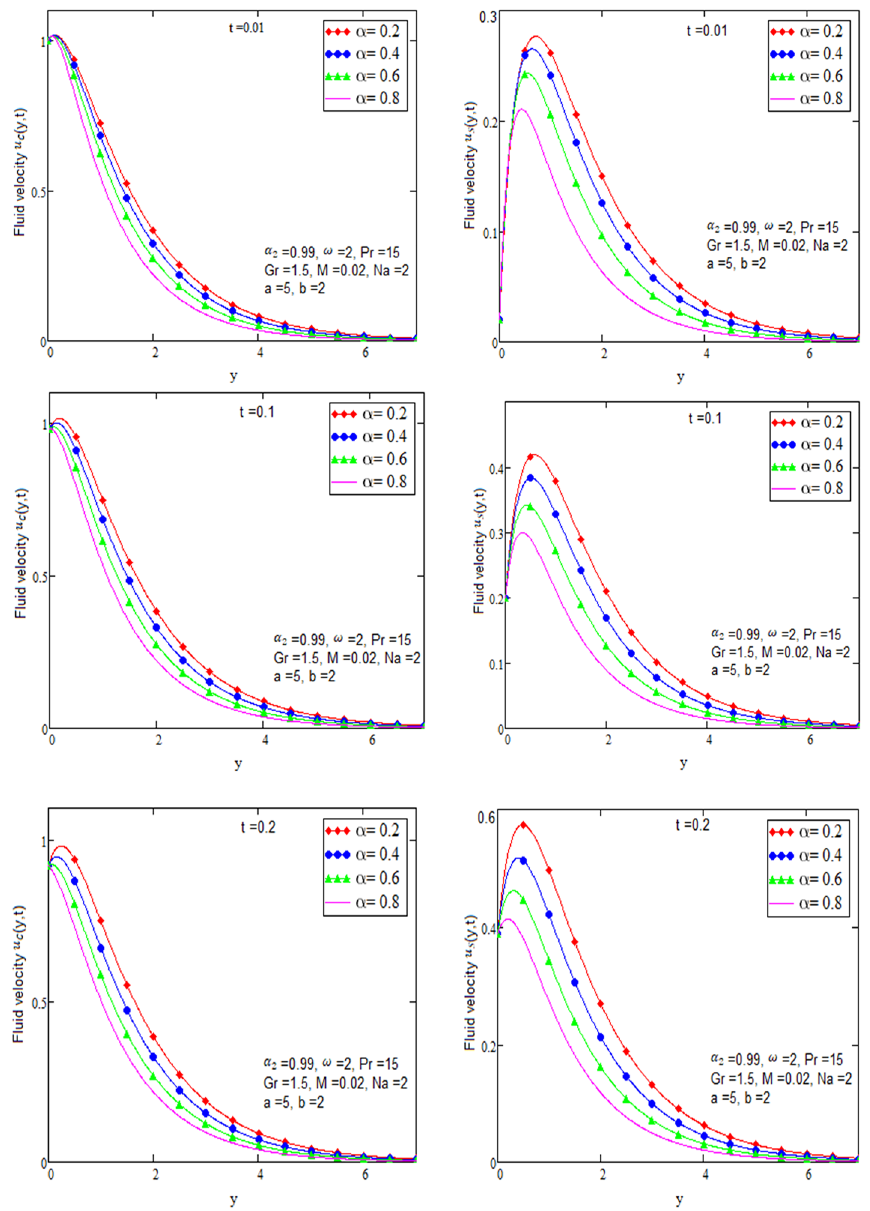
Figure 5. Graph of velocity for different value of alpha α in case of cosine and sine